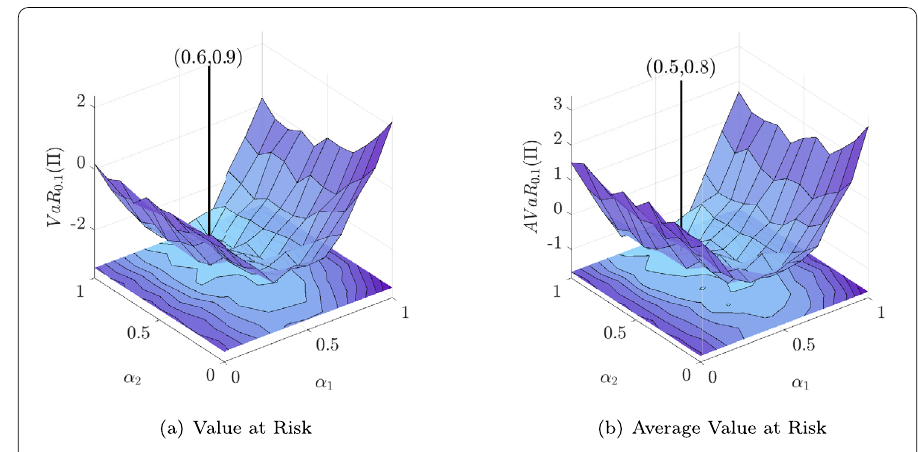
Figure 5 Value and Average Value at Risk with level λ = 0.1 for 1000 samples